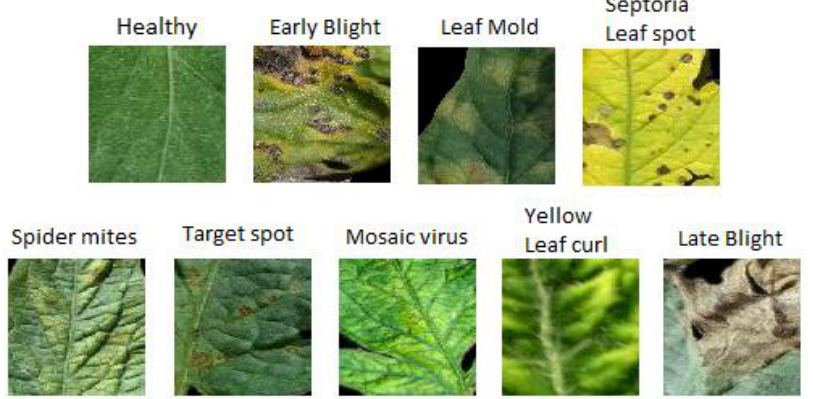
Figure 7. Example of new dataset tiles by class.